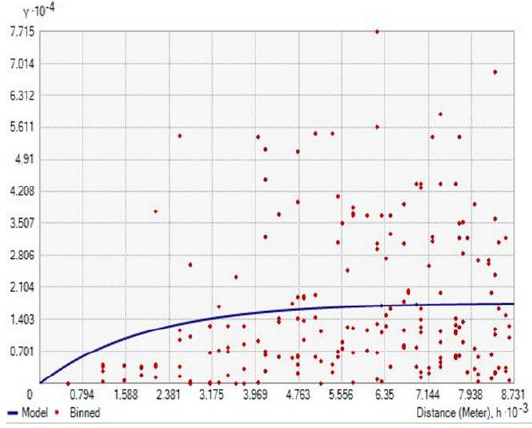
Figure 7. Semivariogram for Aboveground Woody Biomass